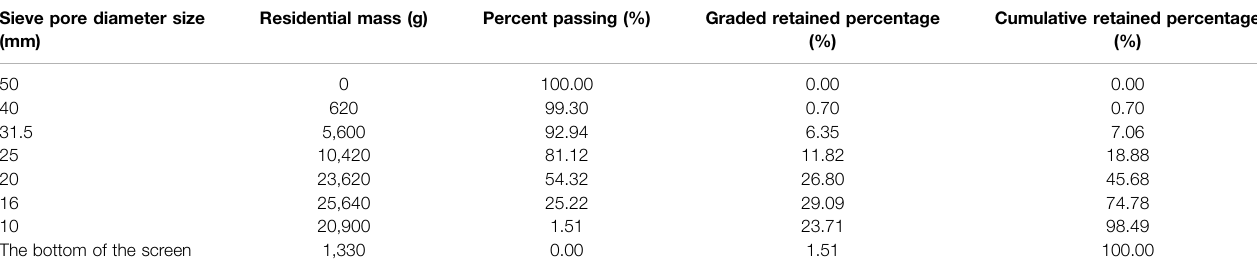
TABLE 1 | Gradation parameters of washed gangue.